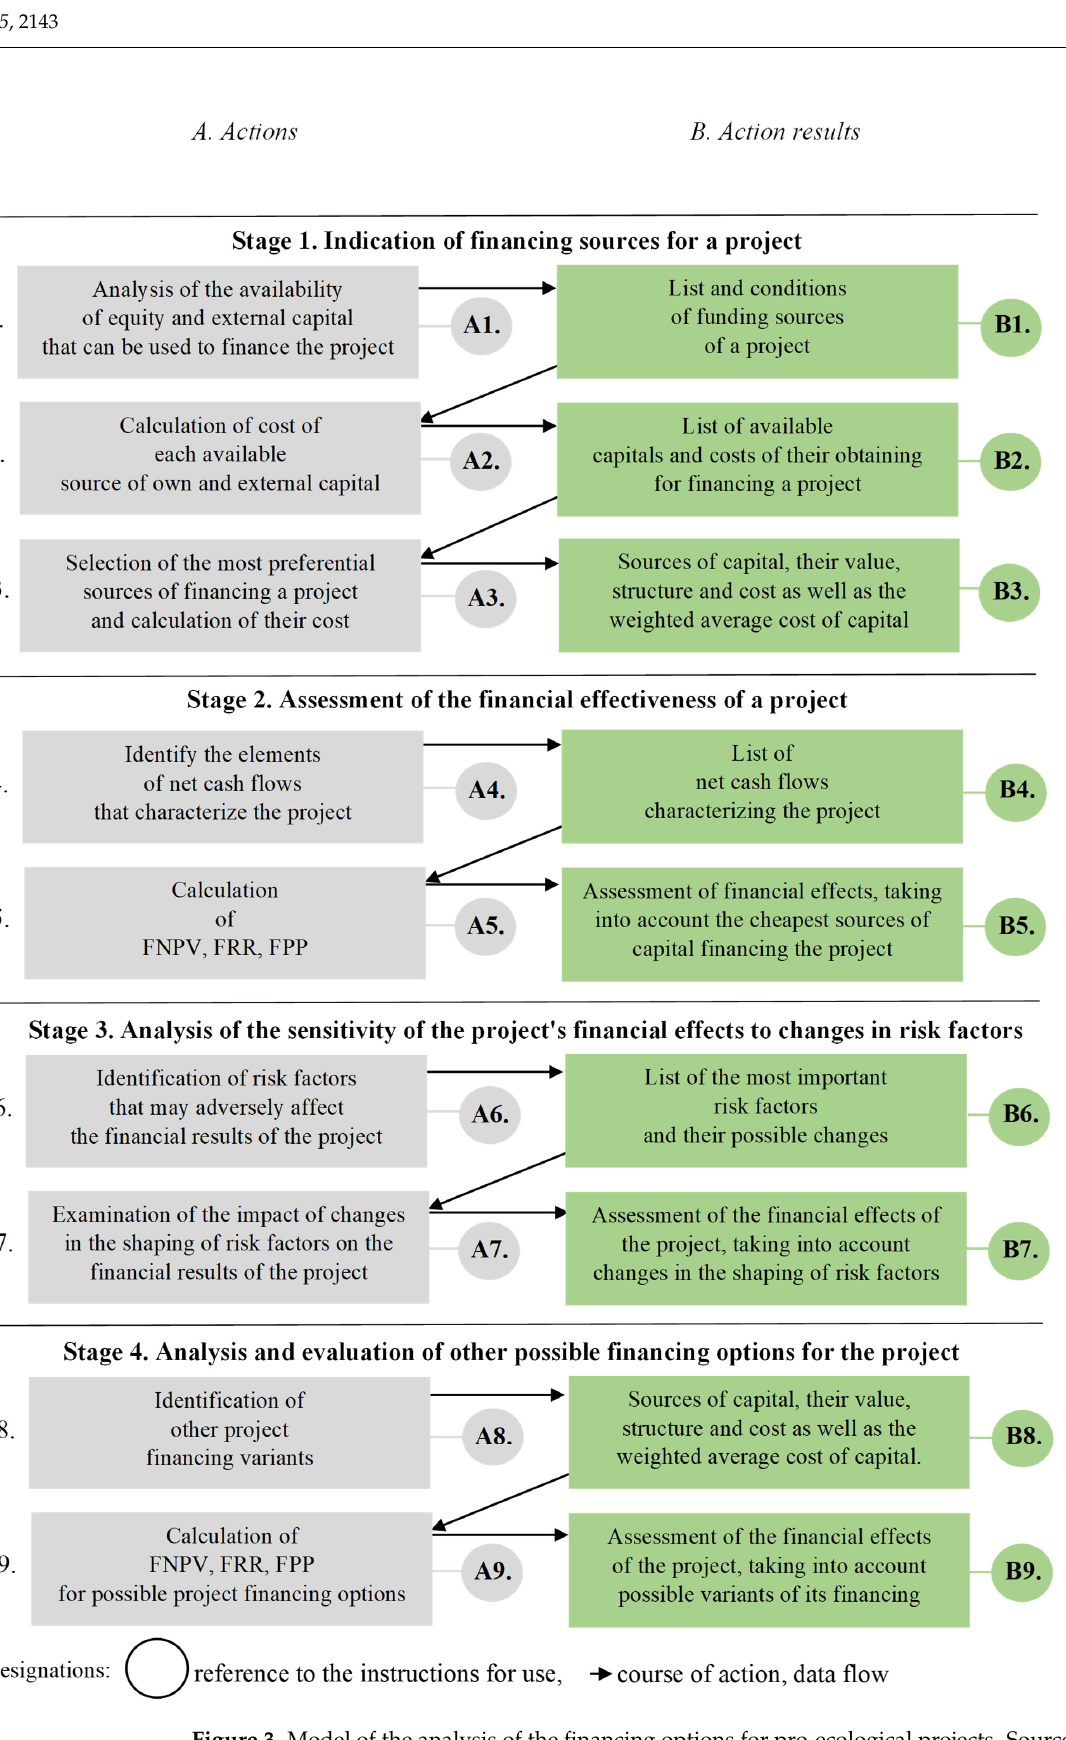
Figure 3. Model of the analysis of the financing options for pro-ecological projects. Source: designed by authors. For each of the stages presented, activities ( A ) have been defined, the implementation of which should end with specific results ( B